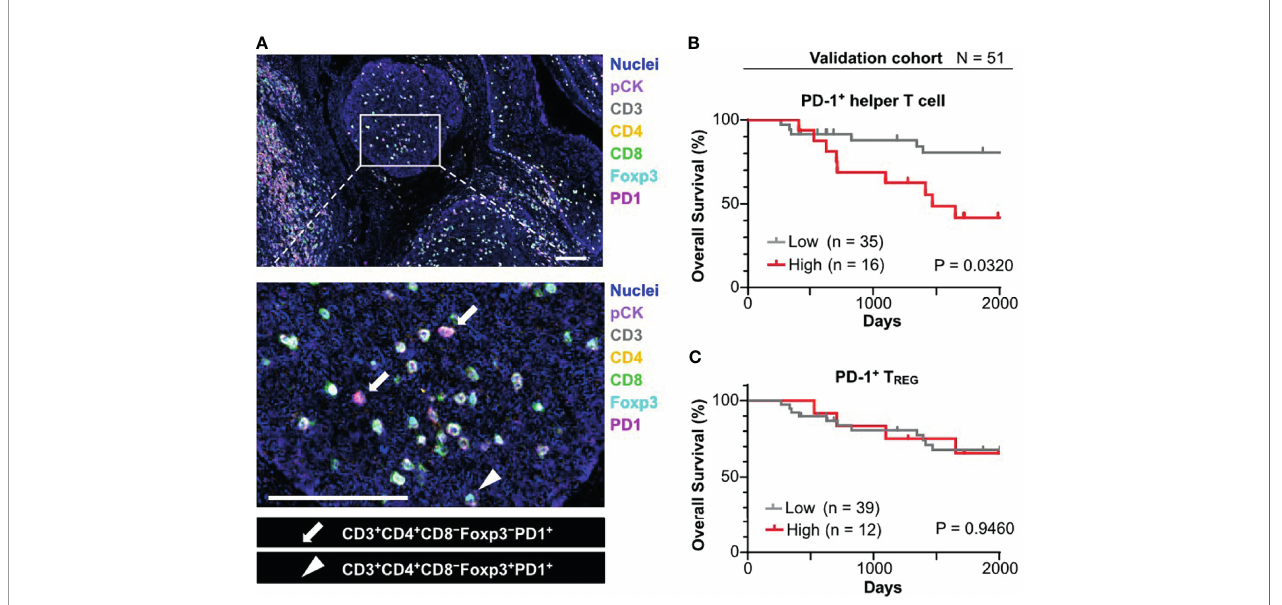
FIGURE 4 | Prognostic signi fi cance of PD-1 + T cell in fi ltrated in tumor cell nests in the validation cohort. (A) FFPE sections of oropharyngeal SCC (N = 58) were analyzed by a 7-marker multiplex IHC panel. Scale bars = 100 m m. (B) Kaplan – Meier analysis of overall survival strati fi ed by density of PD-1 + helper T cell in tumor cell nest. The same cutoff value as in the discovery cohort (43.1 cells/mm 2 ) was applied. (C) Kaplan-Meier analysis of overall survival strati fi ed by density of PD-1 + T REG in tumor cell nest (cutoff = mean). Statistical signi fi cance in (B, C) were determined using the log-rank test.